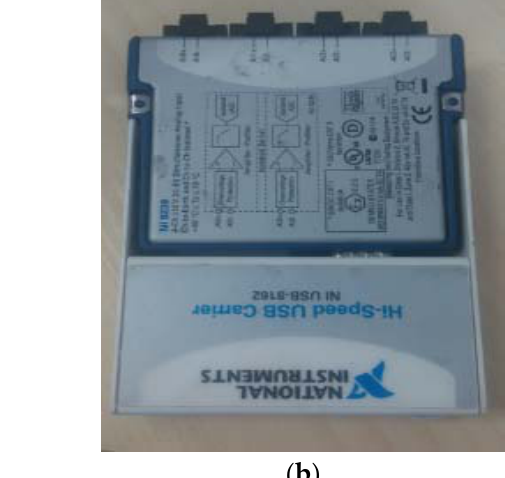
Figure 9. ( a ) Three-component fluxgate sensor of HS-MS-FG-3-LN; ( b ) Data acquisition card of NI 9239.